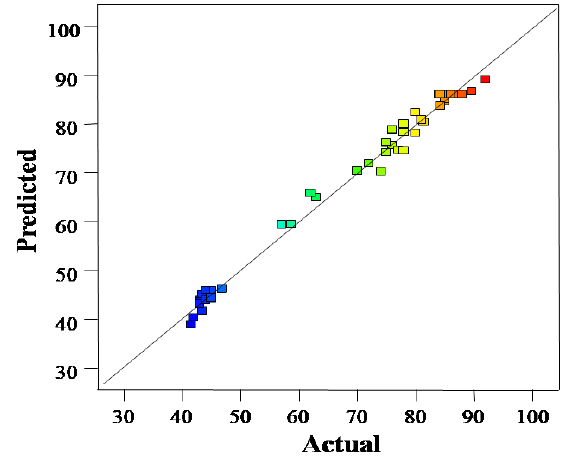
Figure 8. Predicted vs. actual values plot.